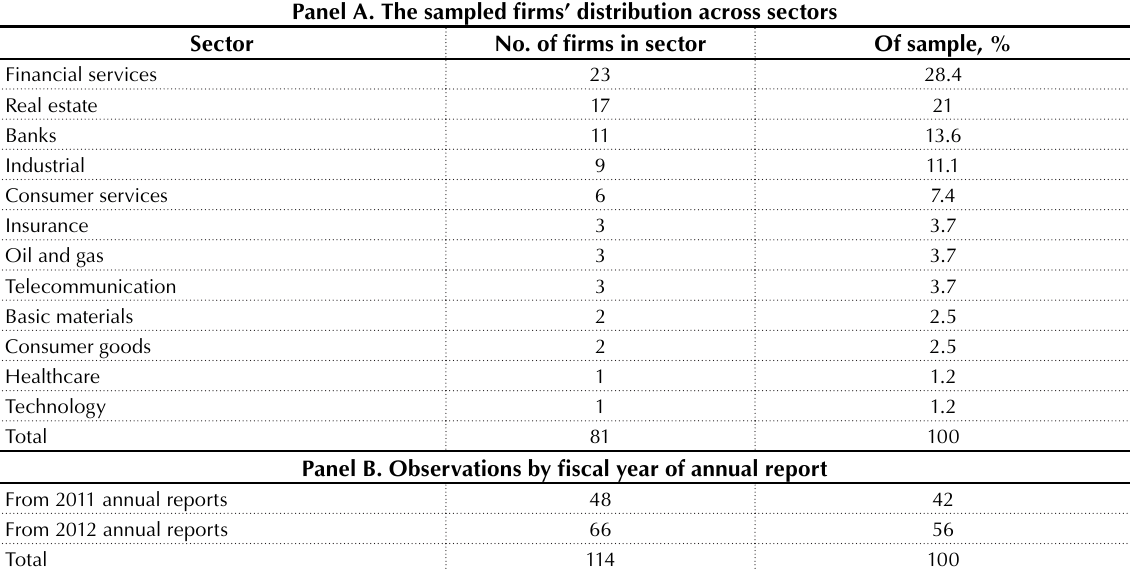
Table 2. Characteristics of the study sample